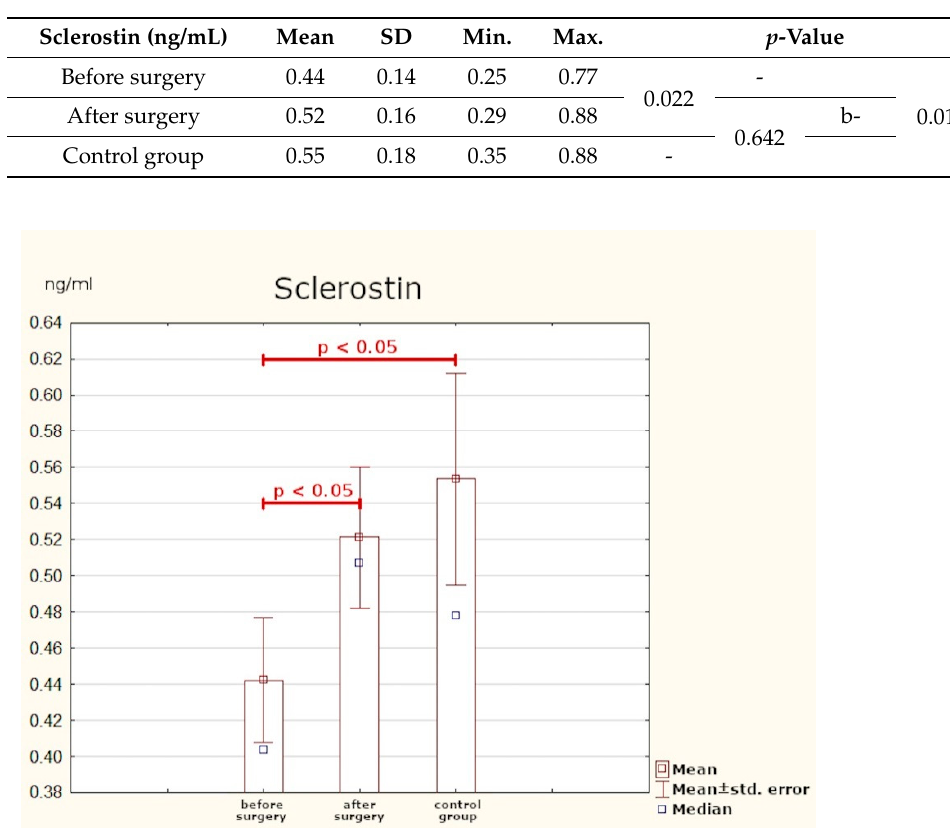
Table 7. Spearman’s rank correlation coefficients (significant in bold).